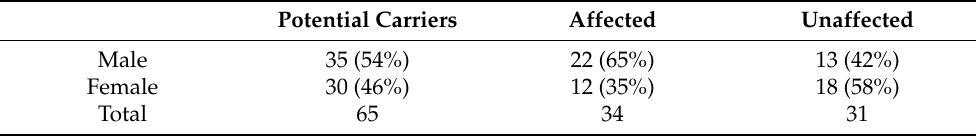
Table 3. Gender disbalance in patients harboring p.G90D in RHO from previous study [17].